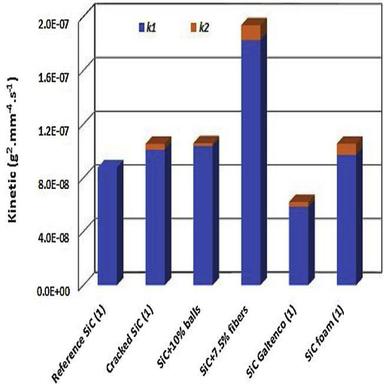
Graphic comparison of the k Hex 1 and k Hex 2 kinetics for the six main samples.